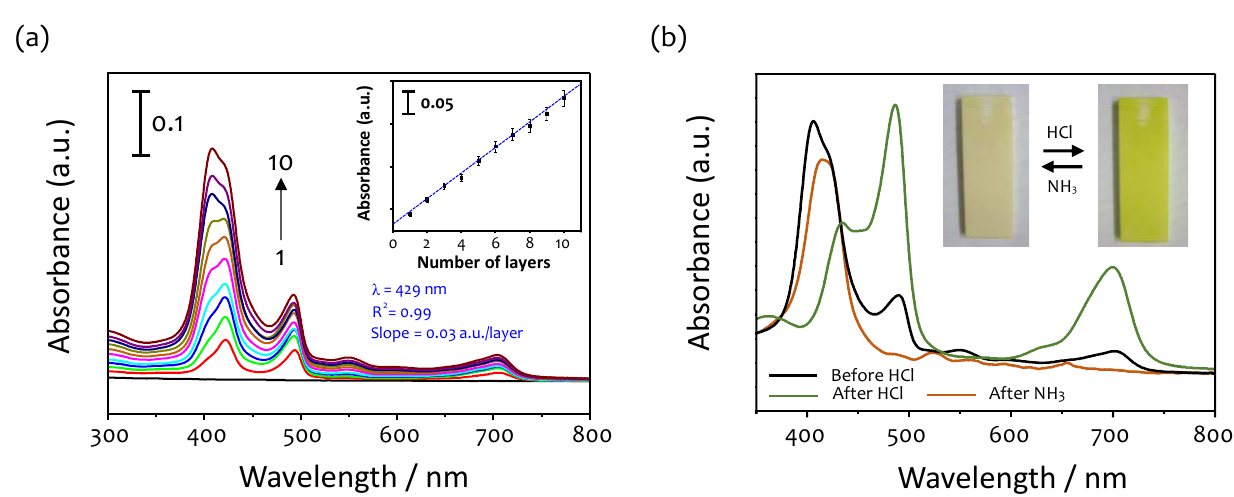
Figure 3. ( a ) Evolution of the UV–vis spectra during the deposition of the PDDA/TSPP film onto the quartz substrate. ( b ) UV–vis spectral changes of the 10-cycle PDDA/TSPP film: the black line represents the absorption spectrum of the as-prepared film, and the green and brown lines represent the absorption spectra after exposure to the HCl (0.1 M) vapor and ammonia (0.1 wt%) gas, respectively. The inset in Figure 3b shows a photo image of the 10-cycle PDDA/TSPP film deposited on a white acrylic plate, depicting the color change after exposure to HCl vapor or ammonia gas.